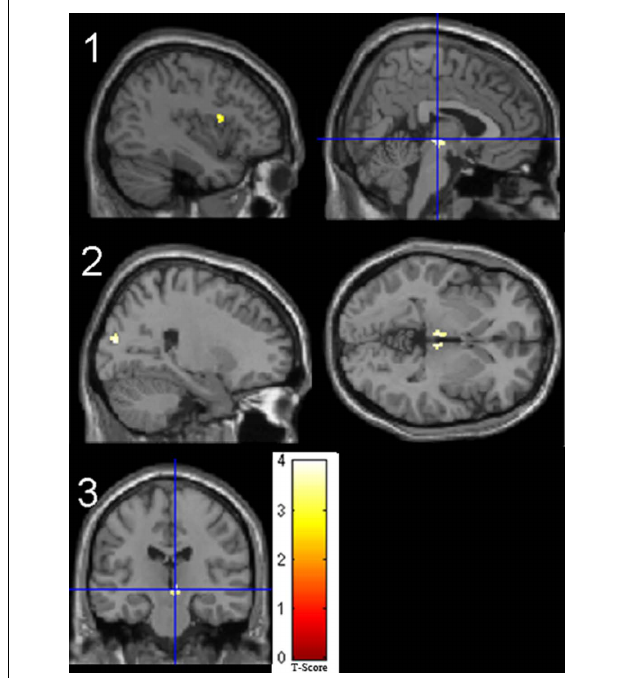
FIGURE 2 | Significant t -test results for patients > controls for the 2back-0 contrast. 1. No covariate (left frontal operculum, right midbrain); 2. Reaction time as covariate (bilateral thalamus, right superior occipital gyrus); 3. BDI as covariate (right red